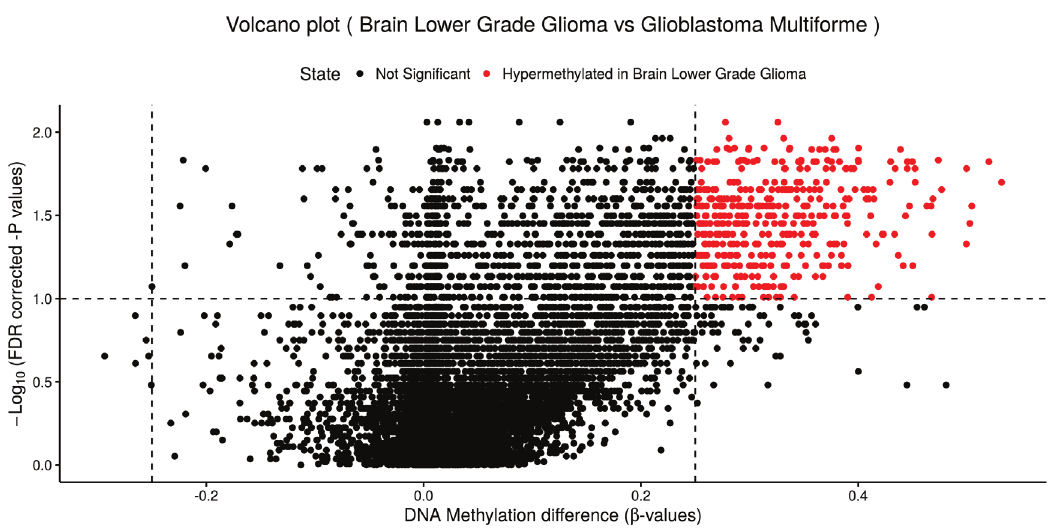
Figure 9. Volcano plot: searching for differentially methylated CpG sites (x-axis:difference of mean DNA methylation, y-axis: statistical